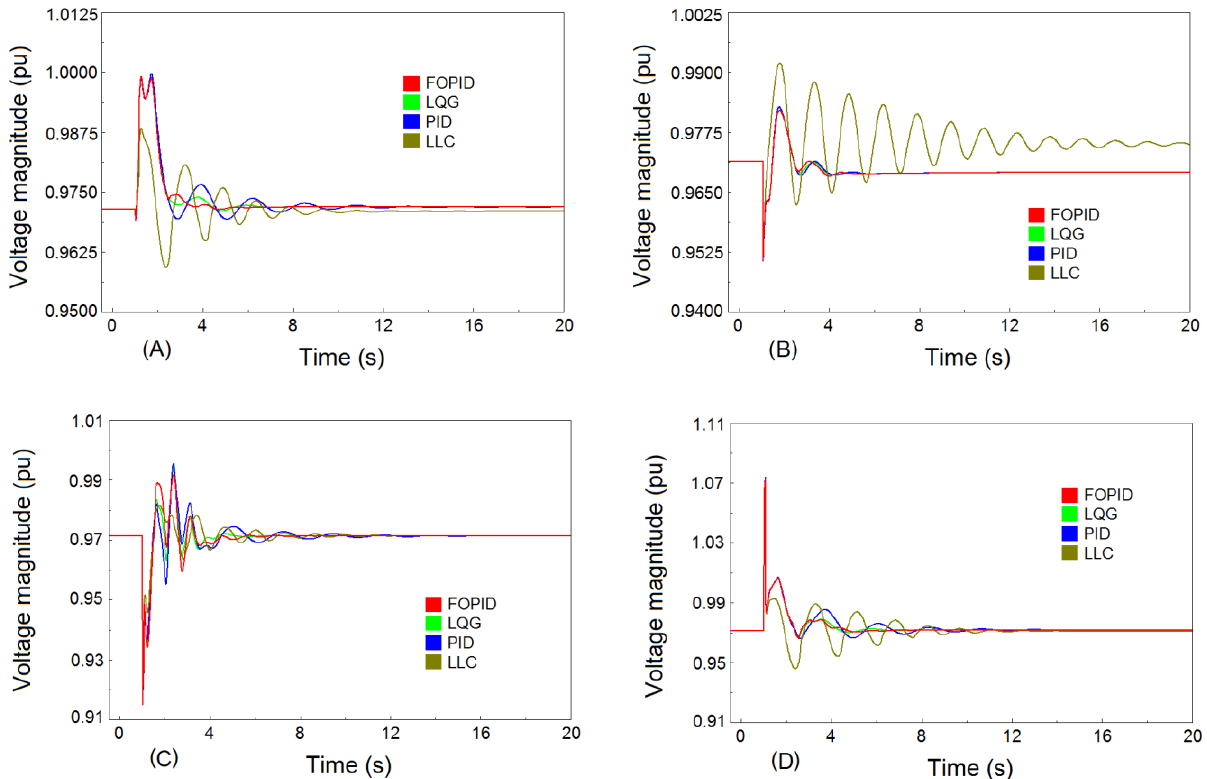
Figure 15. Voltage magnitude at bus 6 for scenario 2: ( A ) state 1, ( B ) state 2, ( C ) state 3, and ( D ) state 4.